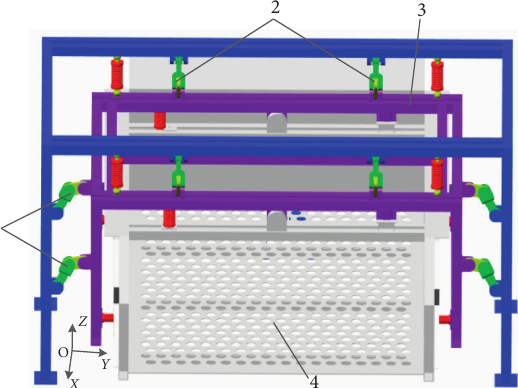
Figure 2: Spatial dimension change principle. 1: vertical constraint chain; 2: horizontal constraint chain; 3: outer screen frame; 4: inner screen